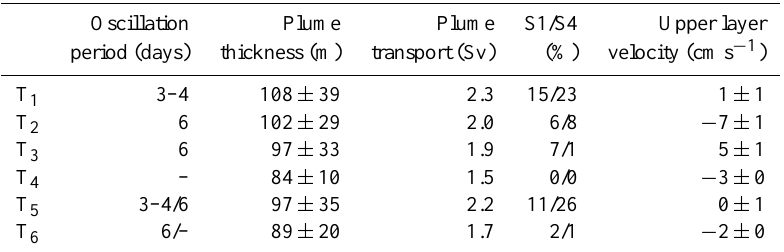
Figure 4. Modelled time series of (a) velocity, u , (b) velocity, v , and (c) temperature, T , at 100mab at the virtual mooring M (see Fig. 1 for location). (d) Wavelet analysis of along-slope velocity at M, 600mab. Red colours indicate high energy and the black line the 95% significance level. Results before and after the thin black lines at the start and end of the record are affected by edge effects. (e) Plume thickness anomaly at M (black line) and at the sill (black, dashed line) and vertical mean EKE from M, normalized by its maximum value. The plume thickness at M is scaled with a factor of 2. (f) Modelled (black line) and observed (black, dashed line) transport across the sill and modelled mean velocity in the along-slope direction in the upper layer (100–300m) at M (red line). Table 3. Plume and oscillation characteristics during T 1 –T 6 . Plume thickness is the mean height of the 6 ◦ C isotherm at S2 ± the standard deviation. Plume transport is the period mean transport obtained from FB. S1/S4 gives the percentage of time that the deepest instrument on the S1 and S4 mooring is surrounded by water colder than 3 ◦ C. Upper layer velocity is the along-slope velocity from S3, 700mab ± the standard deviation of the low passed velocity records shown in Fig.